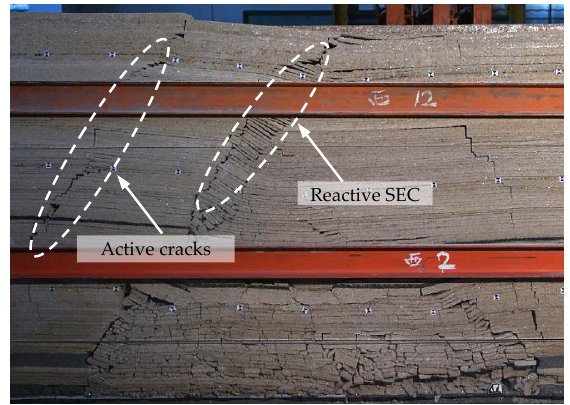
Figure 12. Development of cracks in overlying strata after supercritical mining.